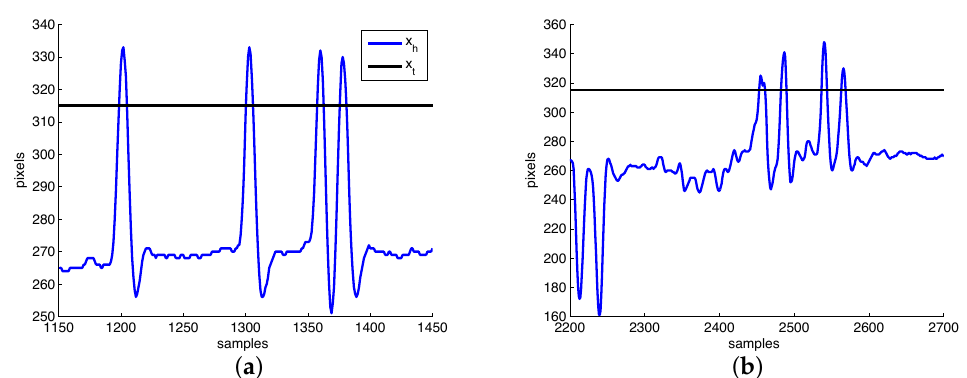
Figure 4. Sample classification results when using the threshold-based method. In ( a ) four succes- sive reaching movement are successfully detected, while in ( b ) false positives due to involuntary movements are depicted.